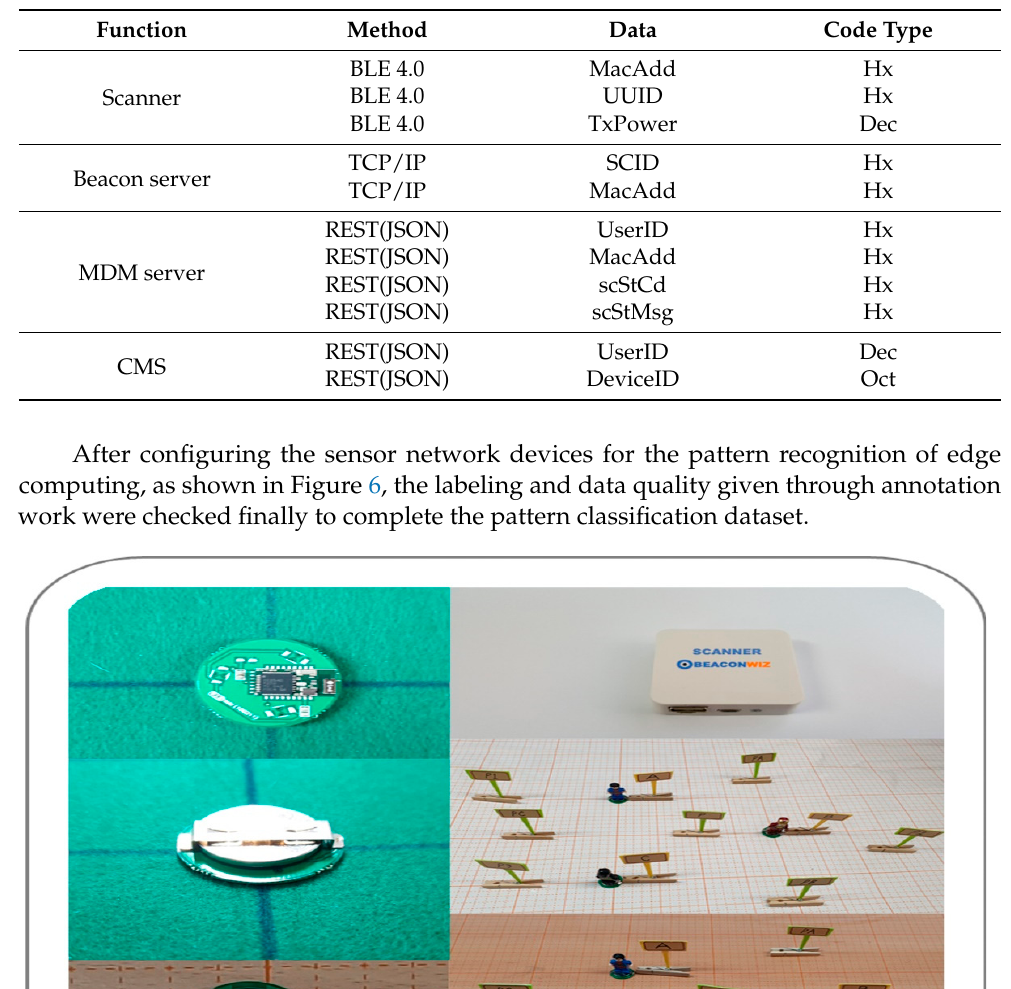
Table 1. Data attributes of the sensor network.